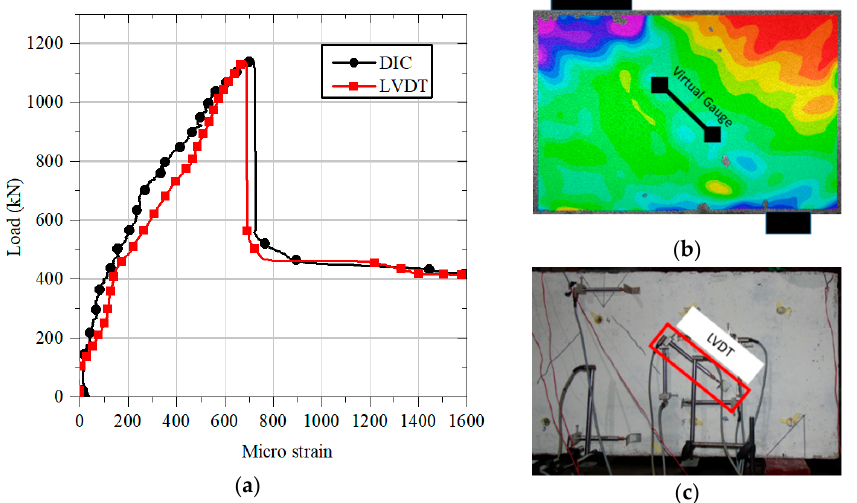
Figure 7. ( a ) Comparison of strain measured using DIC and LVDT, ( b ) Location of virtual gauge in DIC, ( c ) Location of LVDT.